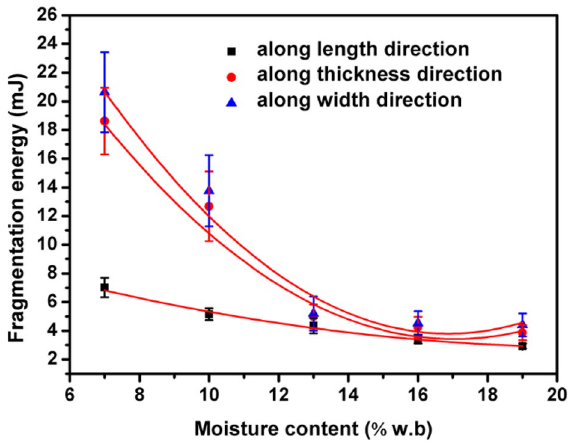
Figure 4. Relationship between moisture content and fragmentation of Cassia tora L. seeds measured along different directions.